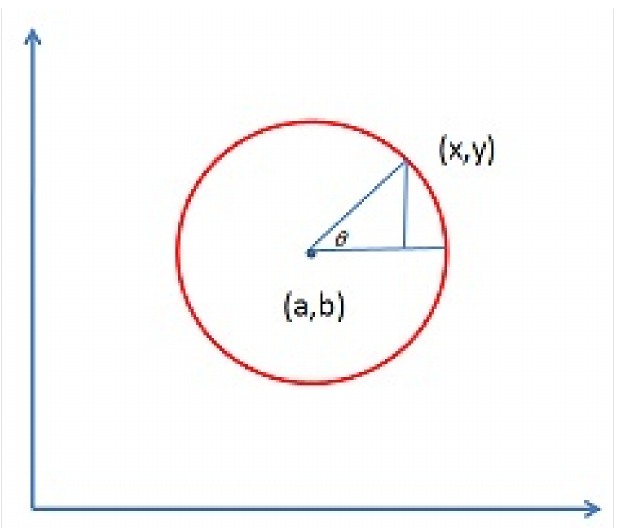
Figure 11. Circles in the Cartesian coordinate